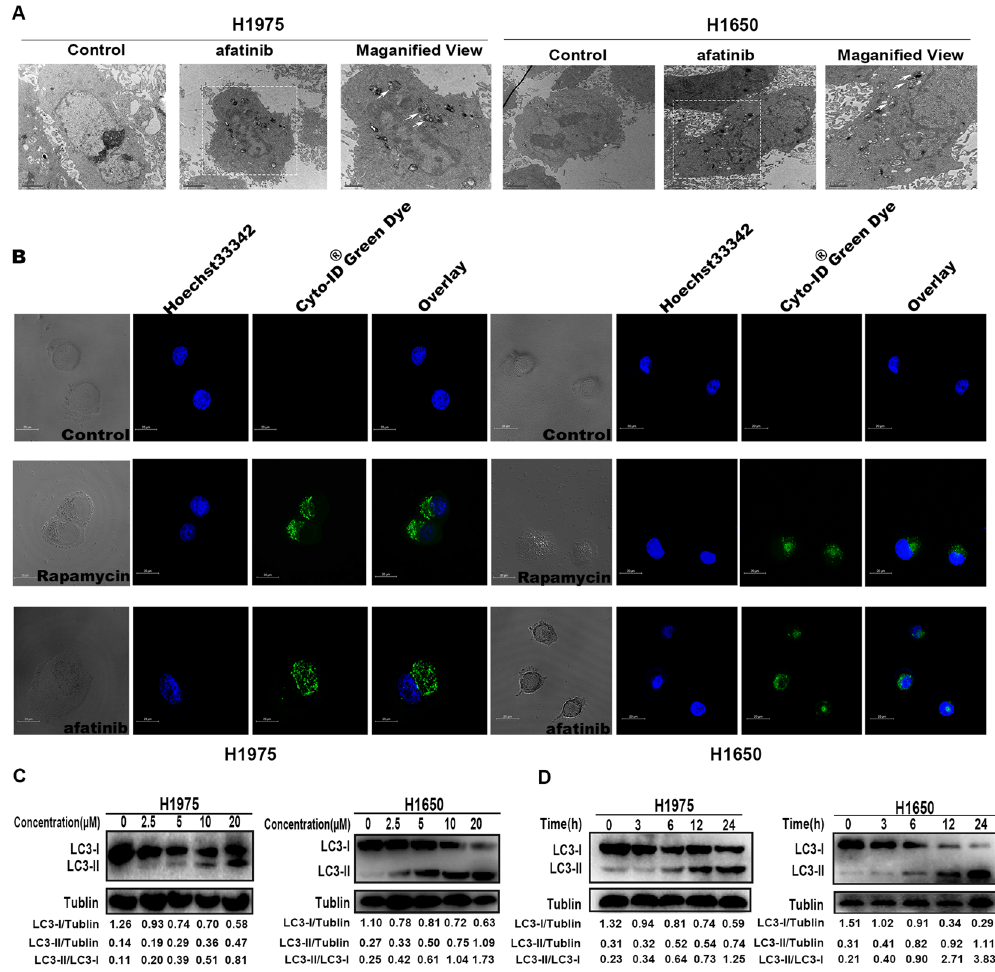
Figure 3. Afatinib induces autophagy in H1975 and H1650 cells. ( A ) H1975 and H1650 cells were treated with 10 μ M afatinib for 24 h. The autophagosomes were observed using TEM (white arrows indicated the autophagosomes). ( B ) H1975 and H1650 cells were stimulated by 10 μ M afatinib for 24 h, then stained by Cyto-ID ® autophagy dye and examined using confocal fluorescent microscopy. 50 nM Rapamycin was used as positive control. ( C ) H1975 and H1650 cells were treated with 2.5, 5.0, 10 and 20 μ M of afatinib for 24 h, then the level of LC3-I/II were measured by western blot analysis. These blots were cropped with Photoshop CS6. The concentration of LC3-I and LC3-II were quantified by ImageJ. ( D ) H1975 and H1650 cells were treated with 10 μ M afatinib for 0, 3, 6, 12 and 24 h, the production of LC3-I/II were measured with western blot analysis. These blots were cropped with Photoshop CS6. The concentration of LC3-I and LC3-II were quantified by